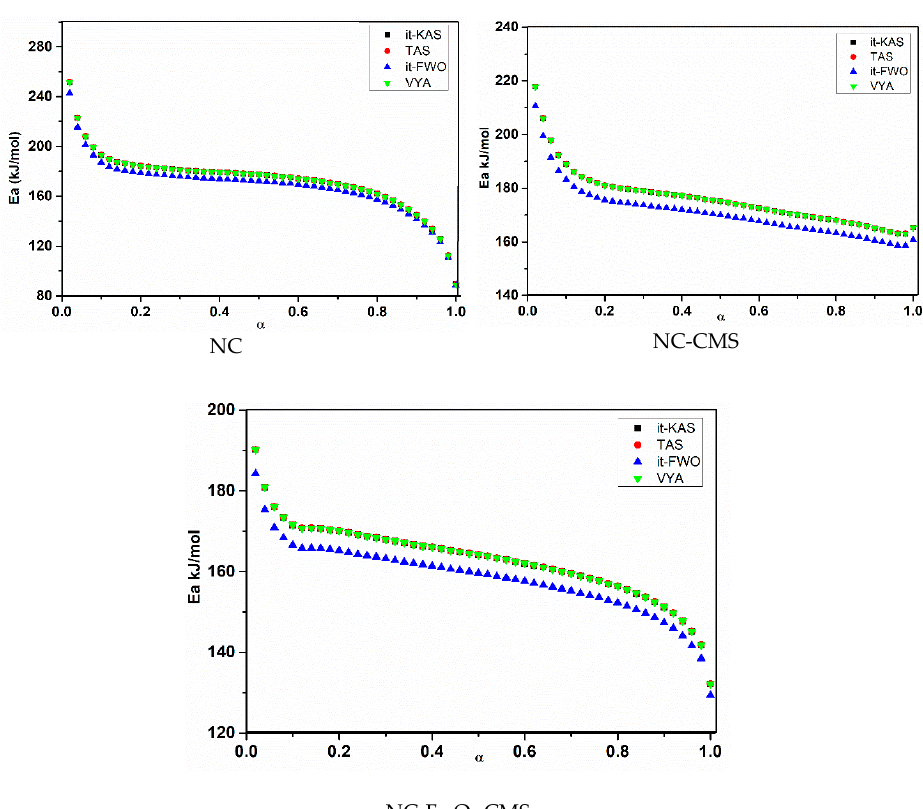
Figure 8. Activation energy ( E a) evolution for the investigated systems by using different isoconversional methods.